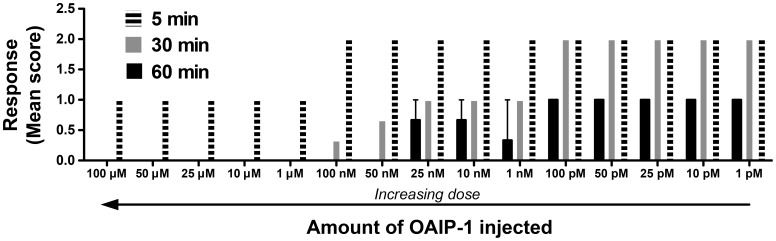
Phenotypic response of insects to OAIP-1.
T. molitor larvae (mealworms) were monitored 5, 30, and 60 min following injection of sOAIP-1 (horizontally striped, grey, and black bars, respectively). The response was scored relative to the control as excitatory (prolonged muscle spasms), excitation to the point of paralysis (spasms so severe the insect was unable to move independently), or death/moribund (dead or, if alive, the insect was unable to right itself when turned on its back). See Table S2 for details for the scoring matrix. No dose produced a depressed state at any of the time points. Columns represent the mean ±SEM of three replicates of 10 insects for each dose.